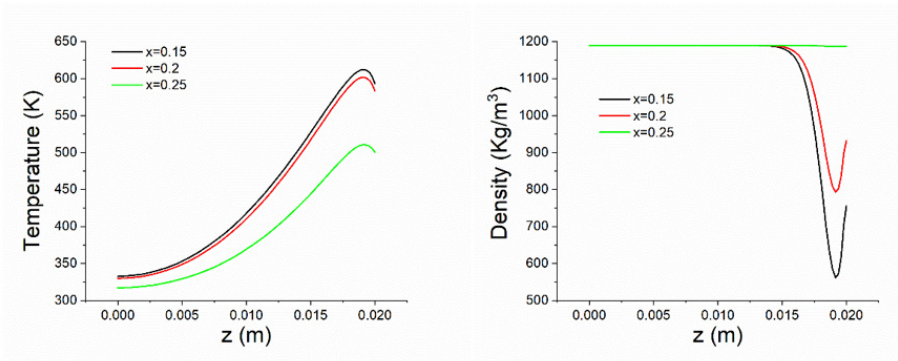
Figure 6. Temperature and density profiles along the depth at different locations.